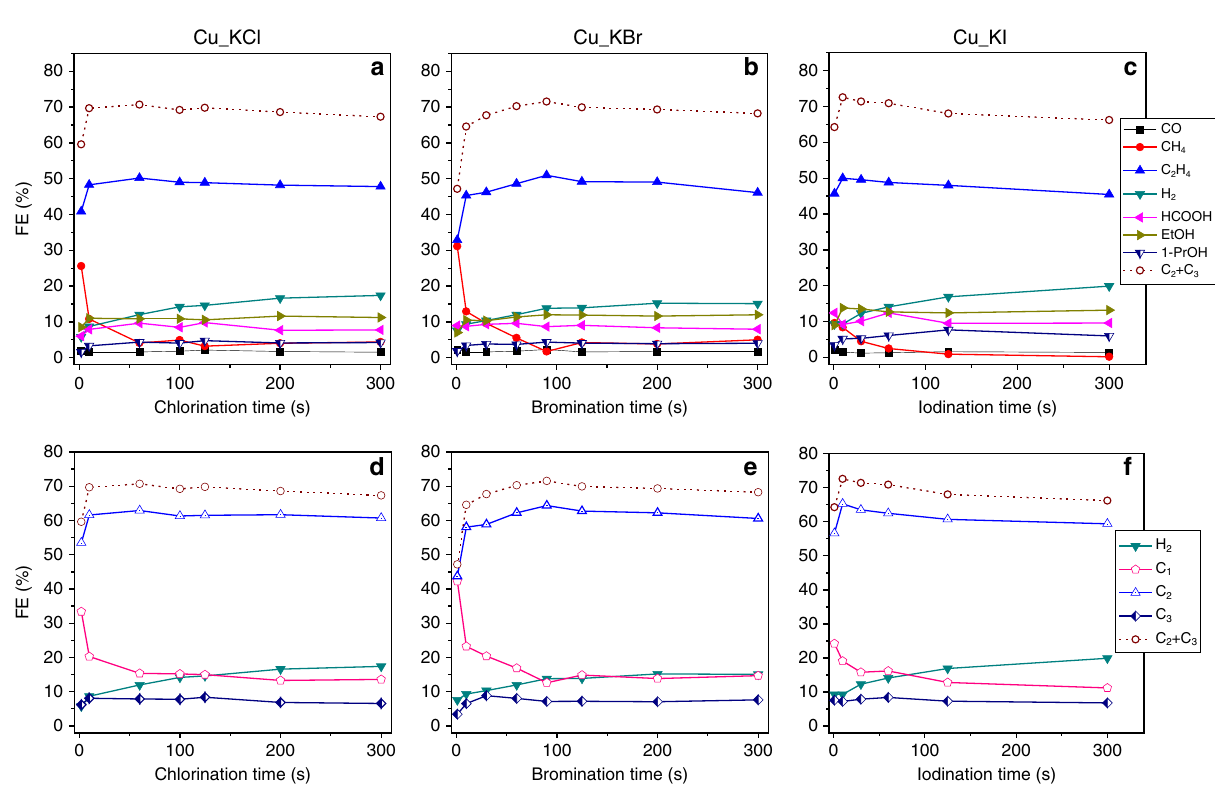
Fig. 6 Effect of halogenation time on the performance of the catalysts for CO 2 reduction reaction. FEs of the products from electrochemical CO 2 RR are shown versus the amount of time the Cu foils were subjected to anodic halogenation in KCl ( a ), KBr ( b ), and KI ( c ). d – f FEs of H 2 , C 1 , C 2 , and C 3 products from the same results shown in the corresponding upper plot. Data were acquired during 40 min of electrochemical CO 2 RR at a constant potential of ~ − 1.11 V vs. RHE in 0.1 M KHCO 3 saturated with CO 2 . Data legends apply to all plots in the same row. Source data are provided as a Source data